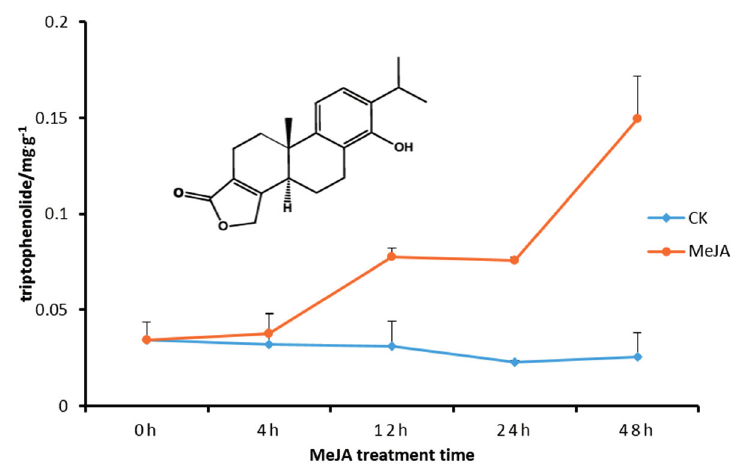
Figure 7. Triptophenolide contents in T.wilfordii suspension cells after treatment with MeJA. The data represented the average of four independent experiments each carried out in triplicate; the error bars showed standard